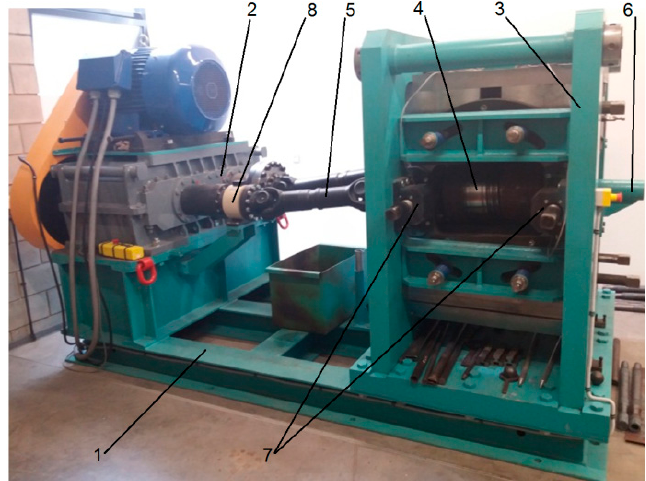
Figure 12. Skew rolling mill: 1—frame, 2—drive unit, 3—rolling cage, 4—working roll, 5—jointed shafts, 6—guiding sleeve, 7—mounting brackets for pressure sensors, and 8—torque sensor.